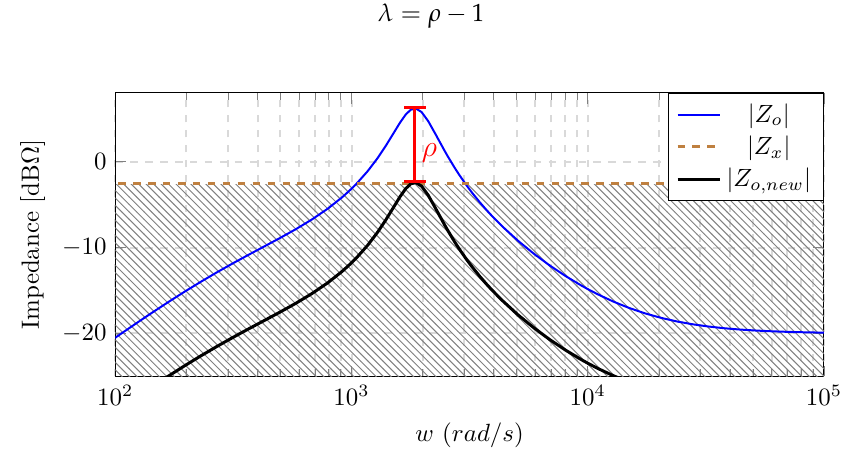
Z o Z x Figure 7. Plots of and showing the reduction factor ρ with the shaped impedance | | | | Z o , new where is proposed to be in the hatched | |